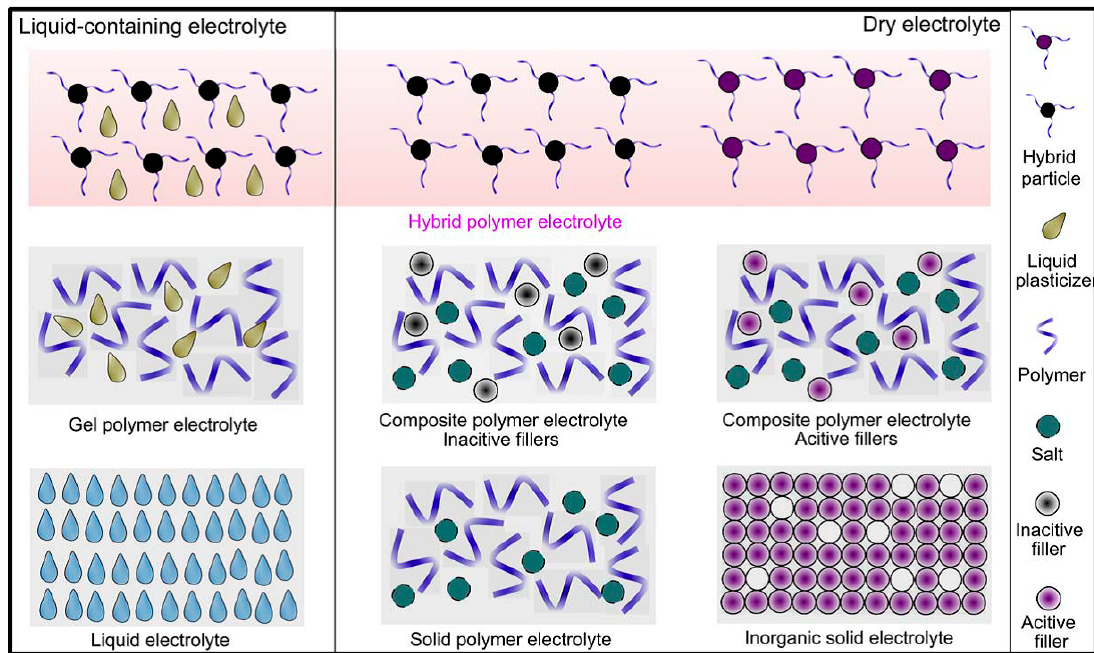
Figure 2. Classification of electrolytes for batteries: Reproduced with permission from [45]. Copyright 2011 Elsevier.